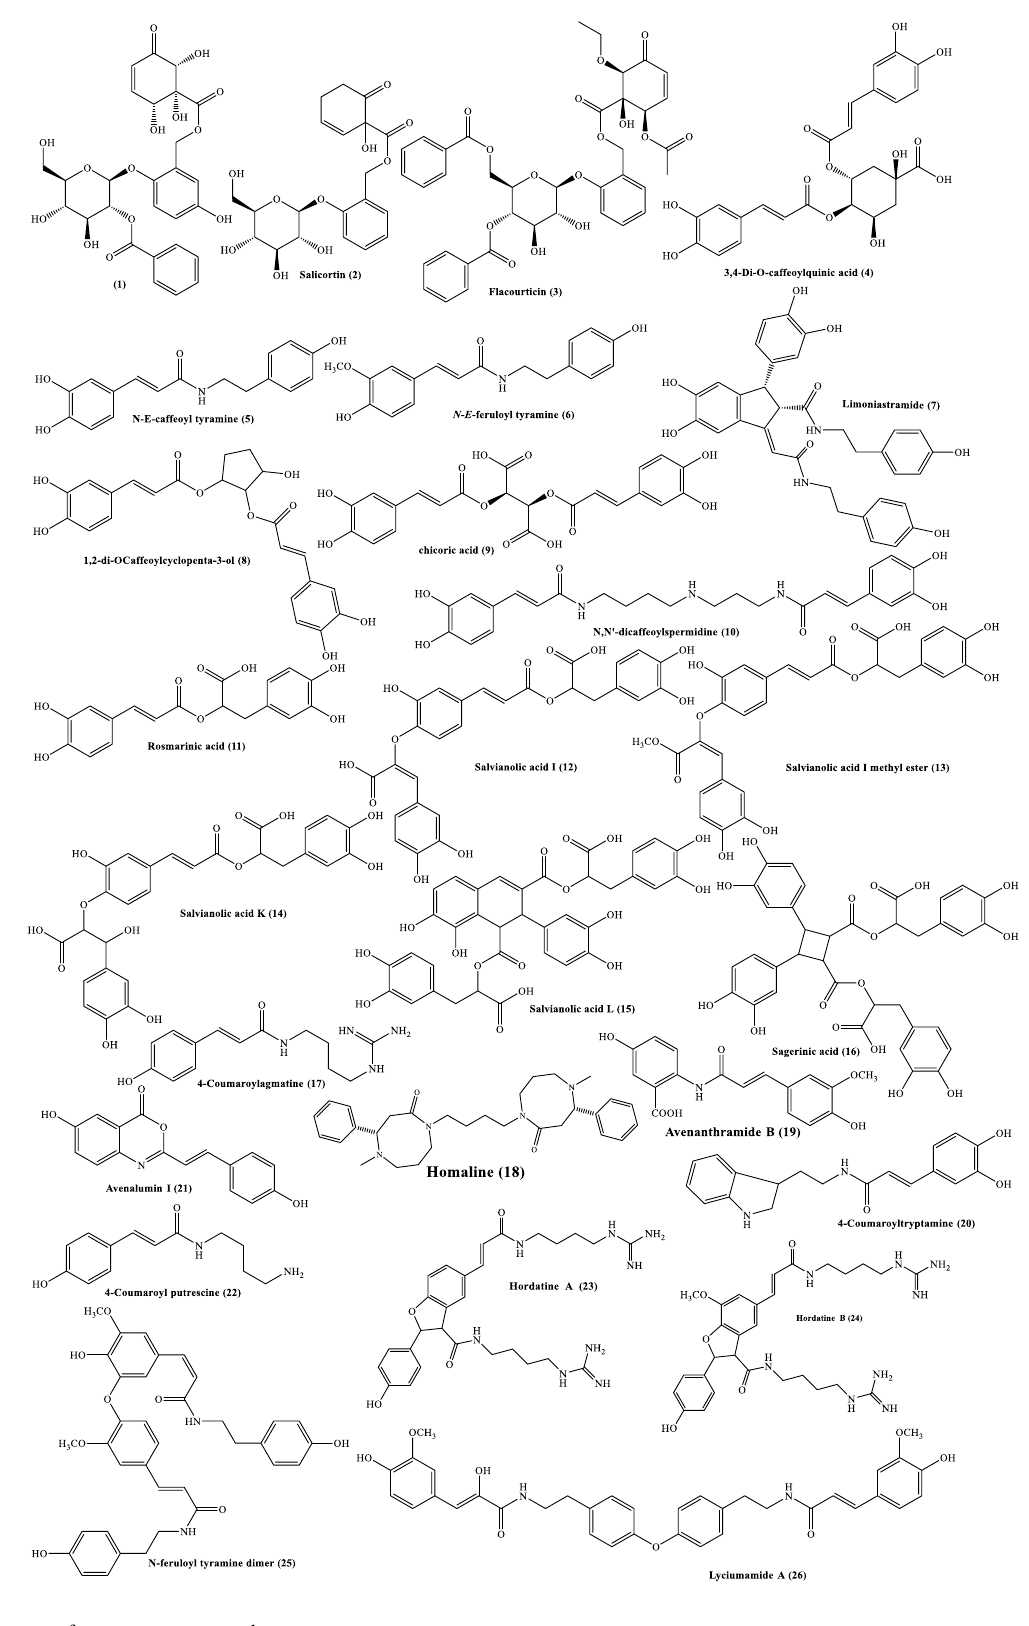
Fig. 1 Structures of our target